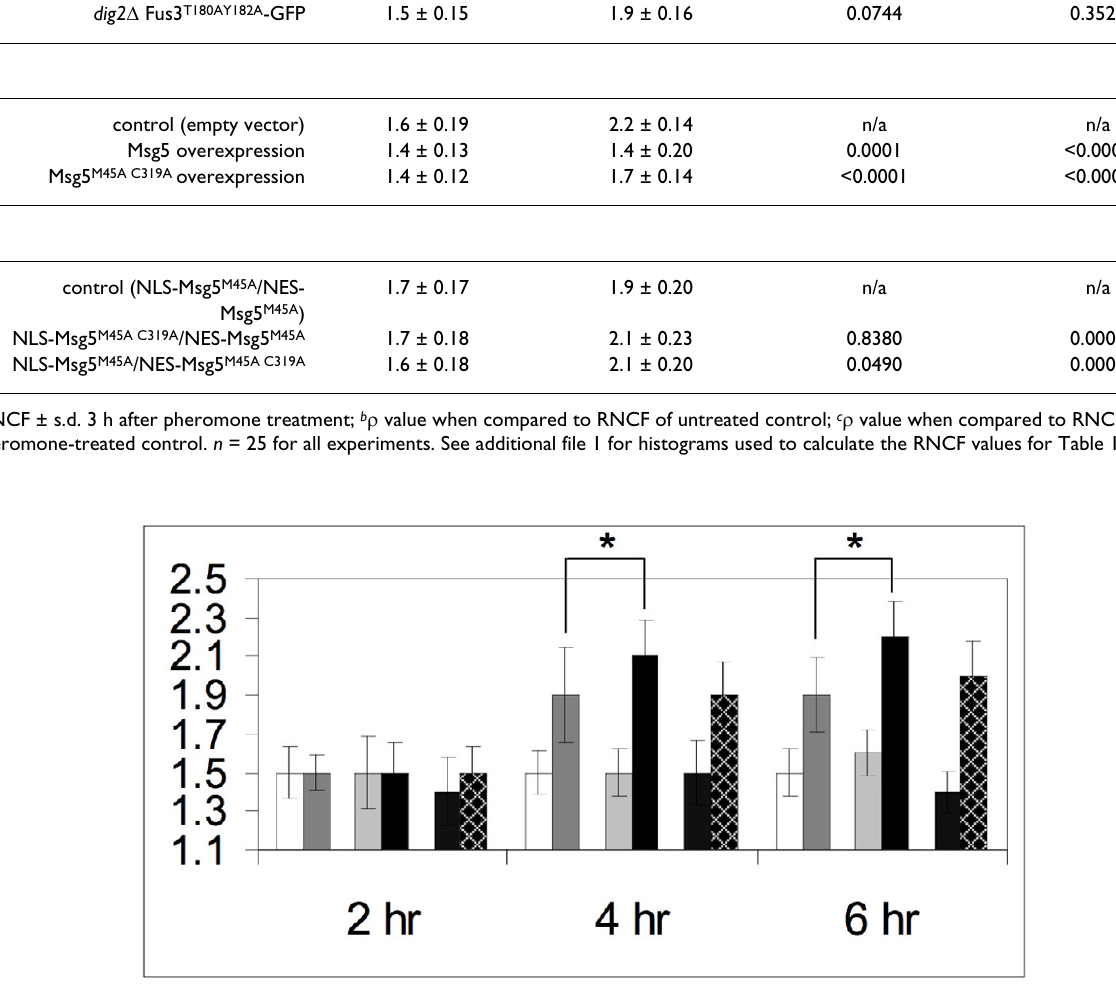
Figure 2 Ste12 overexpression causes hyper-accumulation of Fus3 in the nuclei of pheromone-treated cells . Wild type cells were transformed with either the Fus3-GFP reporter or the Fus3 T180AY182A -GFP reporter, and either the GAL1 -STE12 plasmid or an empty vec- tor. Strains were grown to mid-log phase in sucrose medium and galactose was added to a concentration of 2% two hours before phe- romone treatment ( GAL1 promoter on). The cultures were then split and grown with or without the addition of 12 nM pheromone. Images were acquired from the untreated and treated cultures in 2 hour intervals. The mean RNCF ± s.d. values were determined as described in the Materials and Methods, and are represented in histograms as follows: wild type cells expressing Fus3-GFP–untreated (white bars) and treated (dark gray bars); wild type cells expressing Fus3-GFP and overexpressing Ste12–untreated (light gray bars) and treated (black bars); wild type cells expressing Fus3 T180AY182A -GFP and overexpressing Ste12–untreated (stippled bars) and treated (hatched bars). Asterisks indicate statistically significant differences between strains with ρ = 0.003. See additional file 2 for images repre- sentative of each time point sampled for Figure 2.